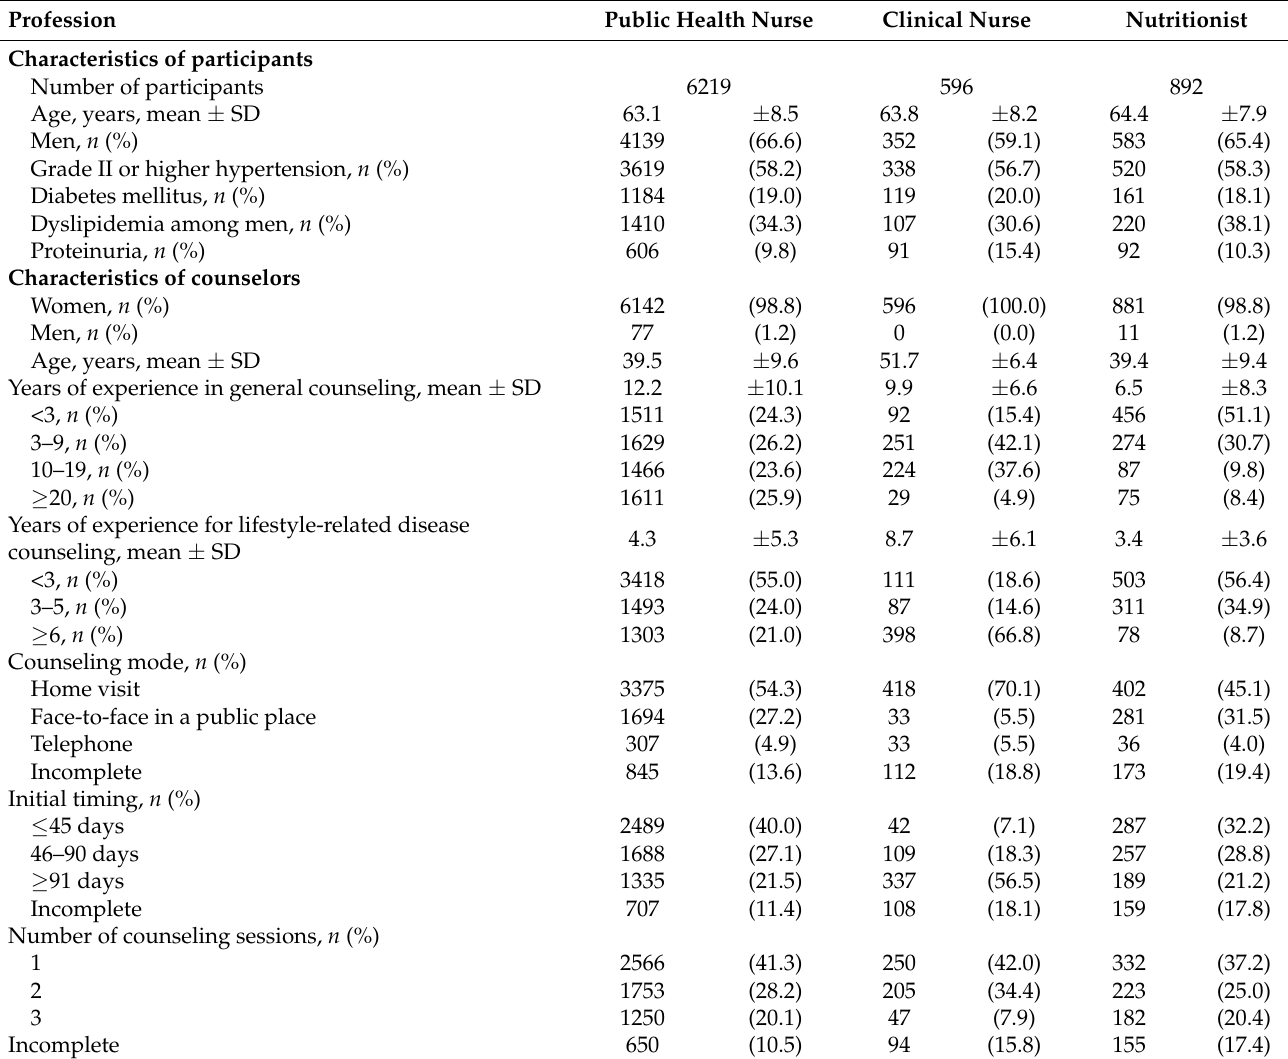
Table 1. Characteristics of the participants and counselors according to the counselors’